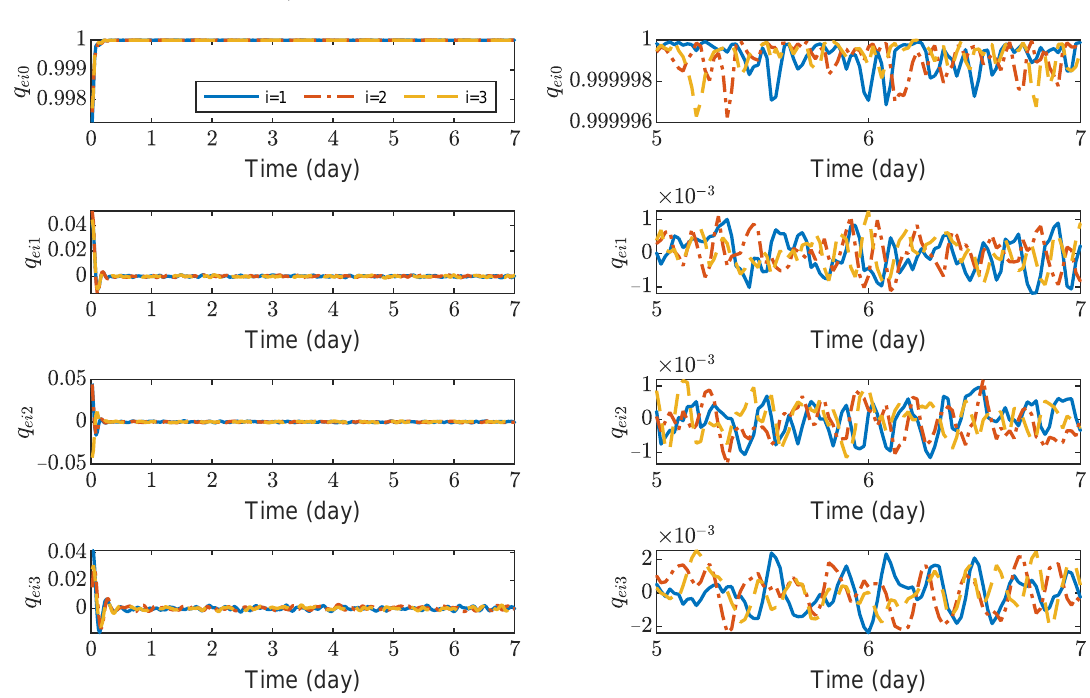
Figure 5. Relative angular velocity errors of spacecraft SC1 ∼ 3, the max control torque of spacecraft is 100 µ N · m.